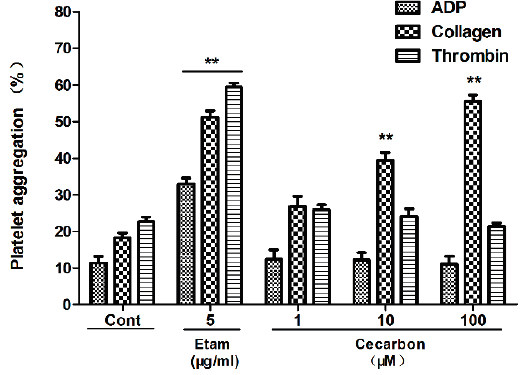
Figure 7. Effect of cecarbon on New Zealand rabbit platelet aggregation induced by ADP, collagen and thrombin. Data were expressed as mean ± SD ( n = 6). The p -values were calculated by non-parametric repeated measures ANOVA (Friedman test) (** p <